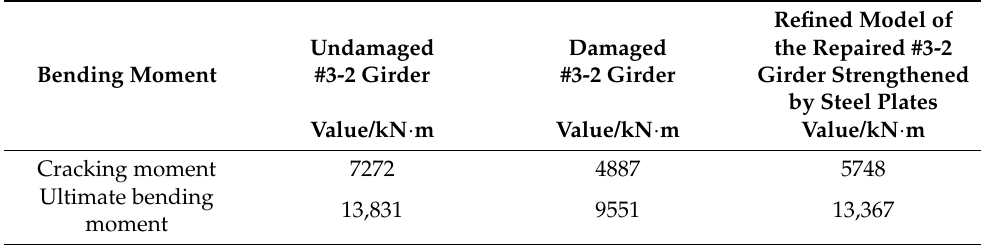
Table 4. The predicted values of the ultimate bending capacity and cracking moment of the #3-2 girder.